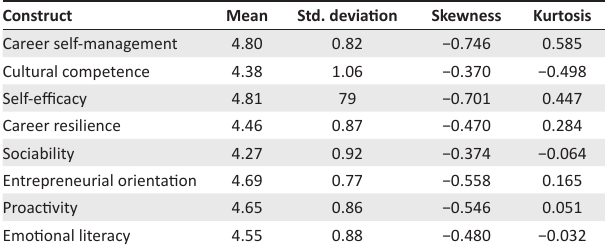
TABLE 1: Means, standard deviations, skewness and kurtosis of the employability attribute scale. Construct Mean